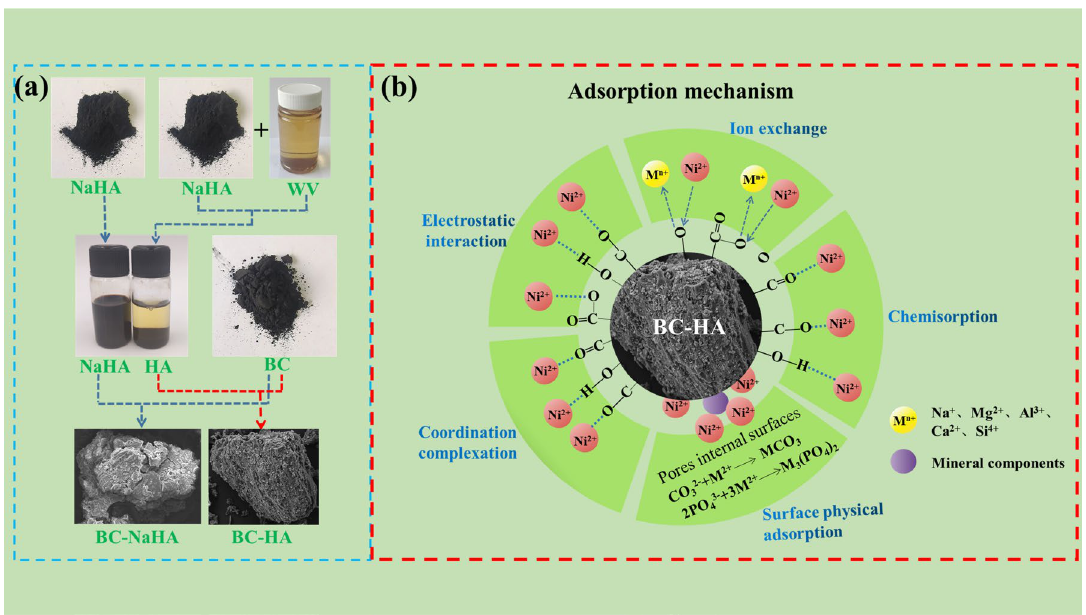
Figure 12. ( a ) Preparation steps of BC-HA material, ( b ) Mechanism Diagram of Ni(II) adsorption by